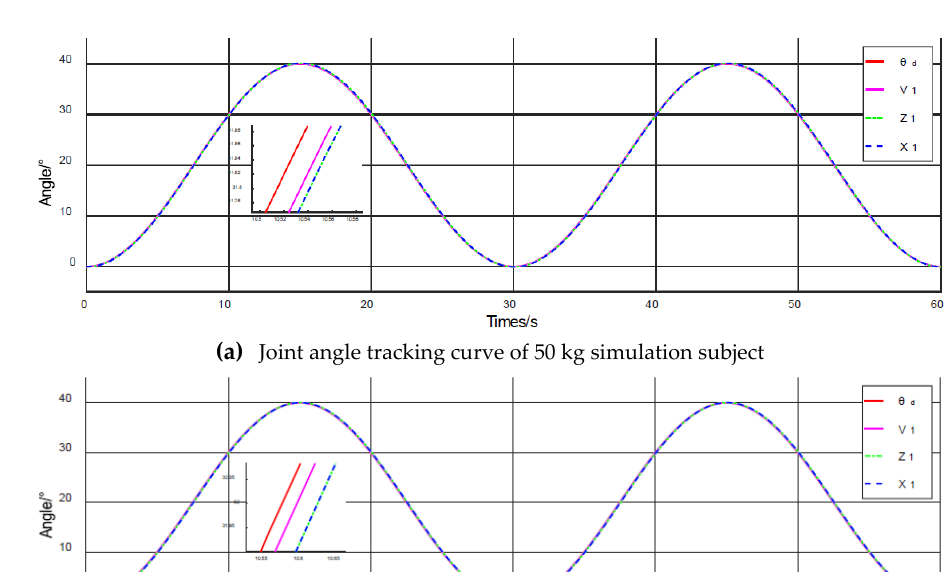
Figure 6. Proportional valve control voltage . Figure 5a,b show the simulation curves when the weight of the load is 50 kg and 80 kg respectively. 𝜃 𝑑 (𝑡) represents the given sine signal of 0–40° and the tracking signal obtained by tracking differentiator; 𝑣 1 (𝑡) represents the tracking signal obtained by 𝜃 𝑑 (𝑡) through tracking differentiator, and it is the expected target of the system; 𝑥 1 (𝑡) is the actual output results based on the active disturbance rejection control system; 𝑧 1 (𝑡)